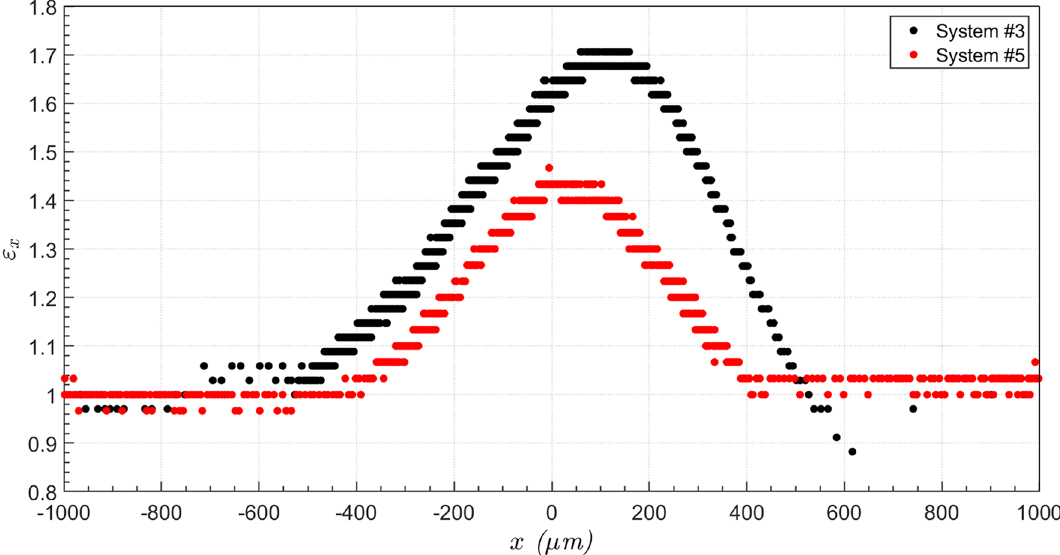
Figure 5. Microcapsule deformation ε x = L x / L x ,0 as it flows through the constriction for capsules from System − 4 #3 ( a = 1.44 and Ca s = 5.9 × 10 ) and System #5 ( a = 1.09 and Ca s = 1.7 × 10